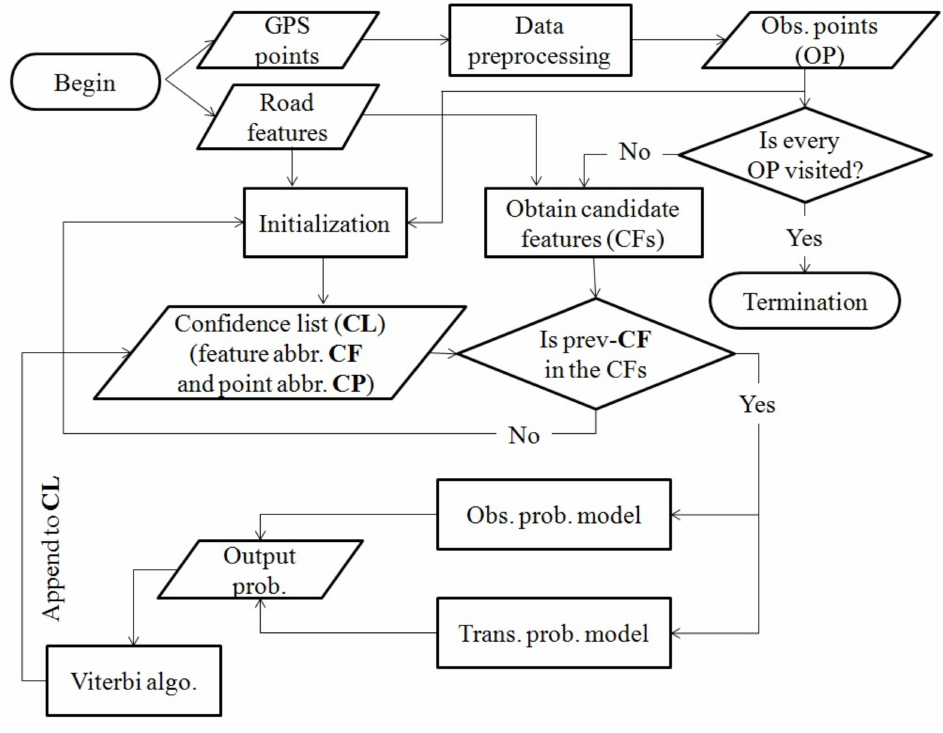
Figure 4. Flow chart of the proposed